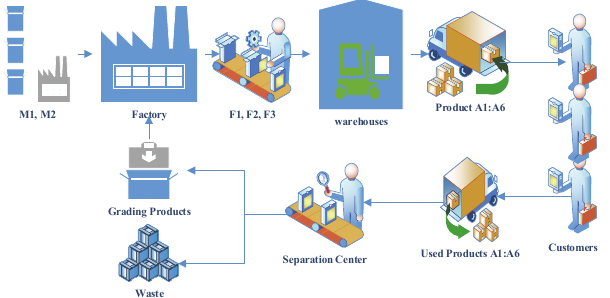
Fig.1. The material flow in the steel closed-loop supply chain